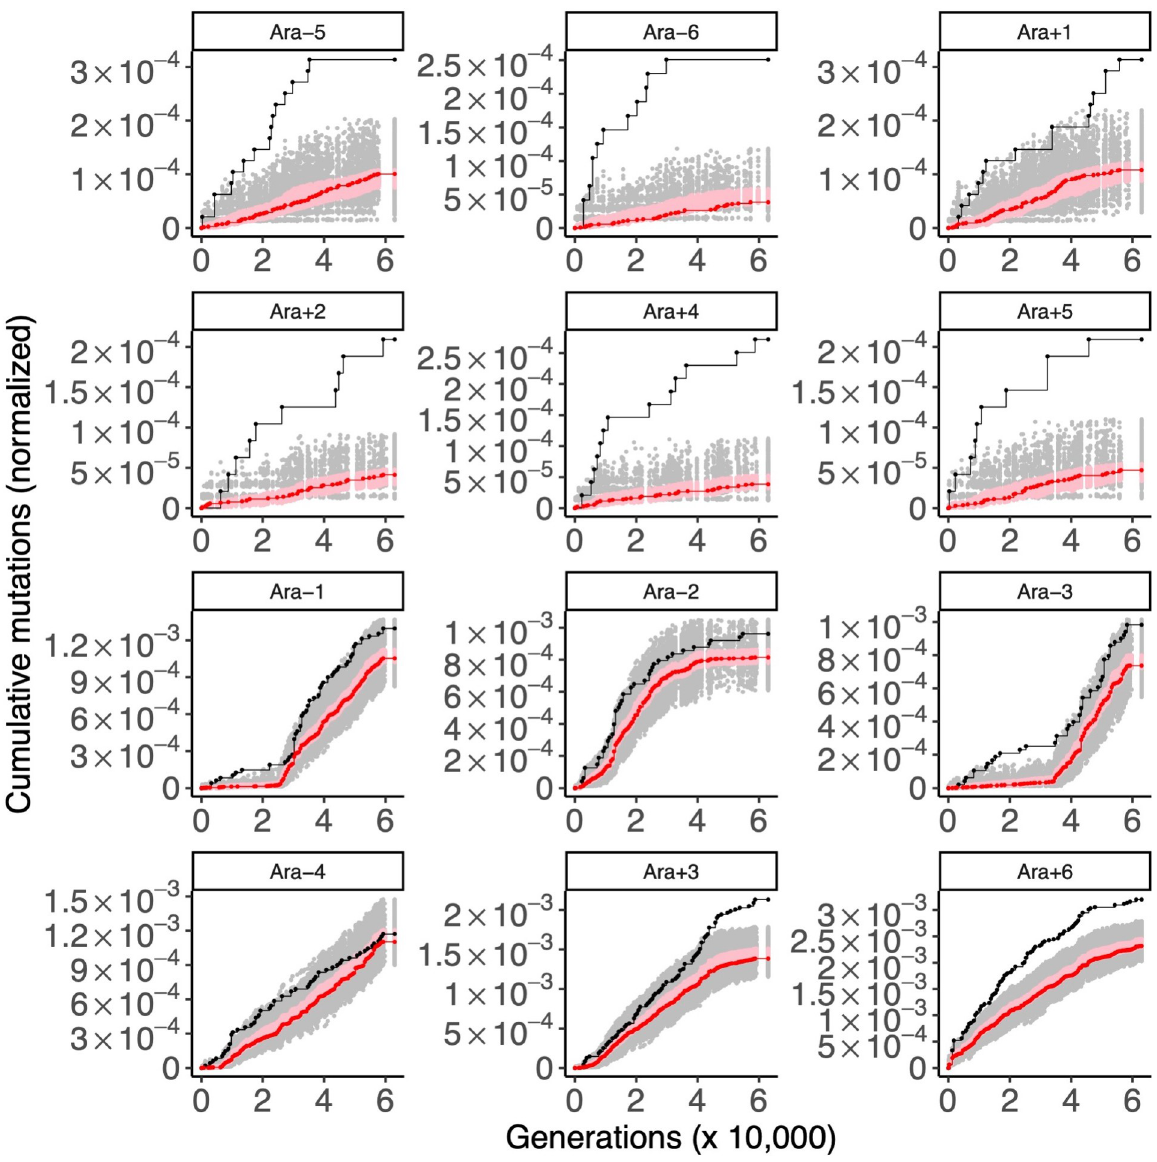
Fig 8. I-modulon regulators evolve under strong positive selection, while genes regulated within I-modulon evolve under weaker selection. Each panel shows the cumulative number of mutations in 56 I-modulon regulators (black) and in 1,061 genes regulated within I-modulons (red) in the 12 LTEE populations. For comparison to the I-modulon regulators, random sets of 56 genes were sampled 1,000 times, and the cumulative number of mutations in those random gene sets, normalized by gene length, were calculated. The middle 95% of the null distribution for I- modulon regulators is shown in gray. A similar procedure was used with random sets of 1,061 genes to make a null distribution in pink to compare to the genes regulated within I-modulons. The top six panels are the nonmutator populations and the bottom six panels are the hypermutator